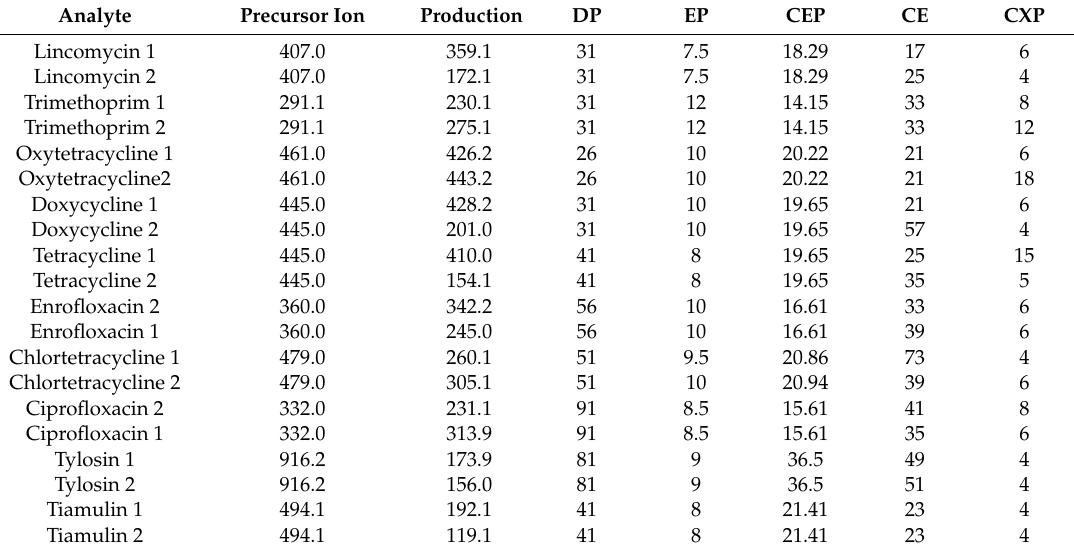
Table 4. Precursor and product ions, declustering potential (DP), collision energy (CE), entrance potential (EP), cell exit potential (CXP) and collision cell entrance potential (CEP) optimal conditions employed for MS identification of each